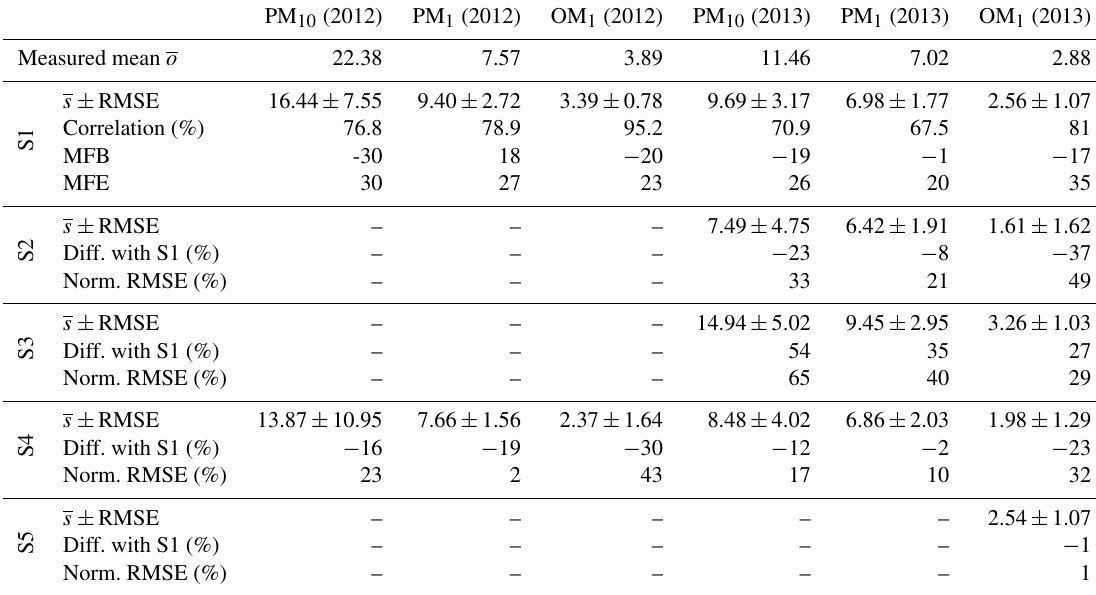
Table 7. Comparisons of simulated PM 10 , PM 1 and OM 1 daily concentrations to observations (concentrations and RMSE are in µgm − 3 ) during the summer campaign periods of 2012 (between 9 June and 3 July) and 2013 (between 7 June and 3 August). s stands for simulated mean and o stands for observed mean. Simulation details are given in Table